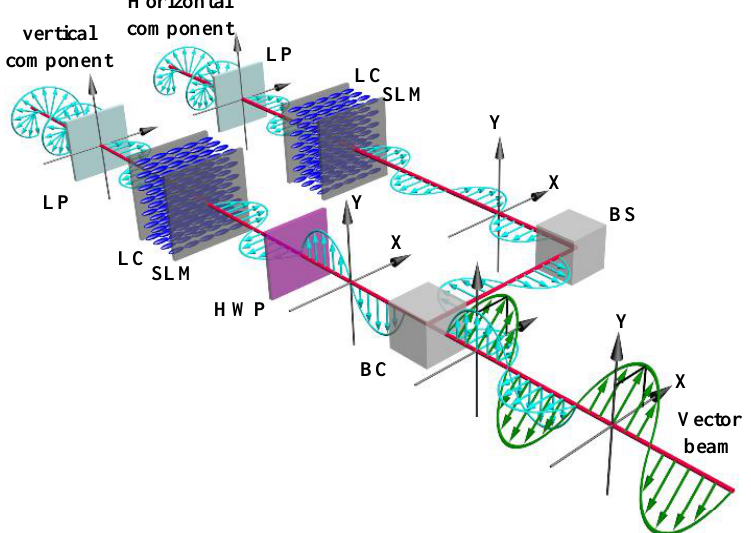
Figure 2. The principle of the proposed method using a tunable optical vector, where LP is a linear polarizer, LC is liquid crystals, HWP is a half-wave plate, BS is a beam splitter, and BC is a beam combiner.